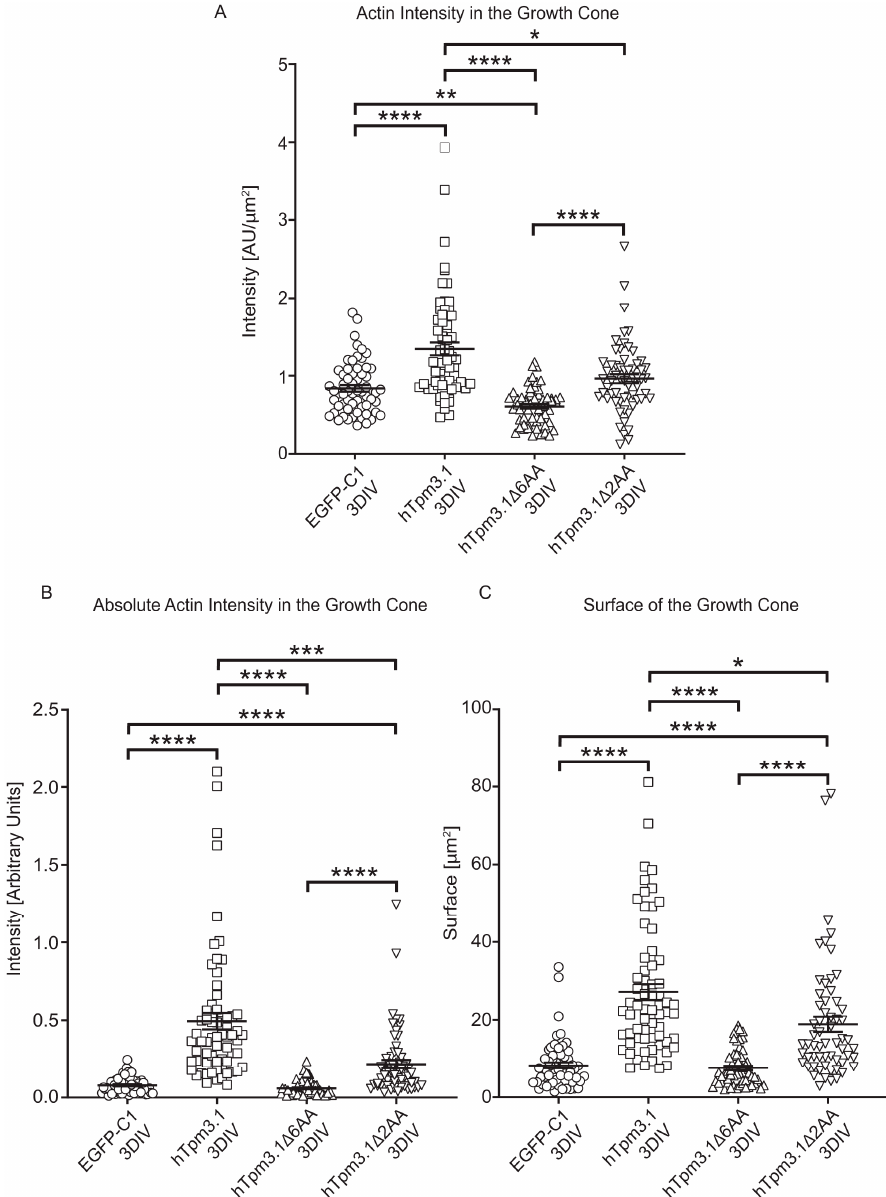
Figure 9. Effects of Tpm3.1 C-terminal truncation on the amount of F-actin at the growth cone. Actin intensity in the growth cone was measured as mean fluorescence intensity of the area of the growth cone in phalloidin channel ( A ). Absolute actin intensity in the growth cone was obtained by multiplying the value of actin intensity by the growth cone surface ( B ). Surface of the growth cone was measured by manually outlining the area of the growth cone and measuring the surface ( C ). 60–69 growth cones from four biological replicates (with at least 5 growth cones per replicate) were analysed for each construct. Error bars represent standard error of the mean. Significance was determined by Kruskal–Wallis test with Dunn’s correction for multiple comparisons: * p <